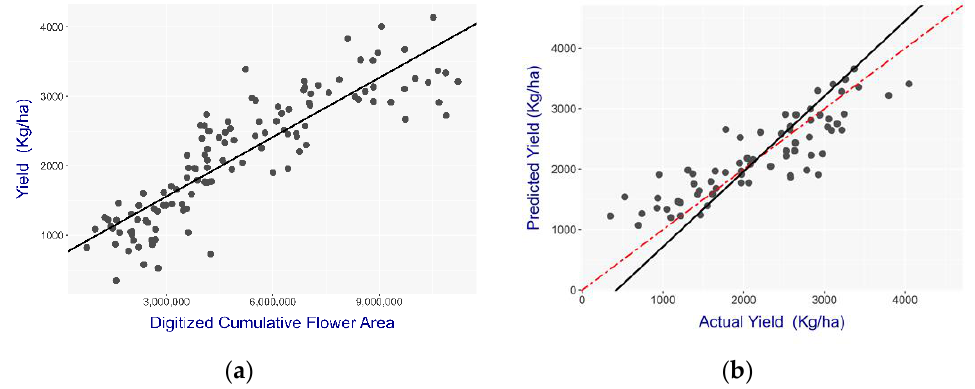
Figure 11. ( a ) The trained model and ( b ) the scatterplot of the measured vs. predicted canola seed yield for the testing set developed for the cumulative flower area (Model 4). Red line indicates the 1:1 line. Table 6. Parameter estimates of the trained simple linear regression model for the cumulative flower area. Table 7. Pearson ’ s correlation coefficient (R) and root mean squared error (RMSE) of the valida- tion plots from the four canola seed yield models.